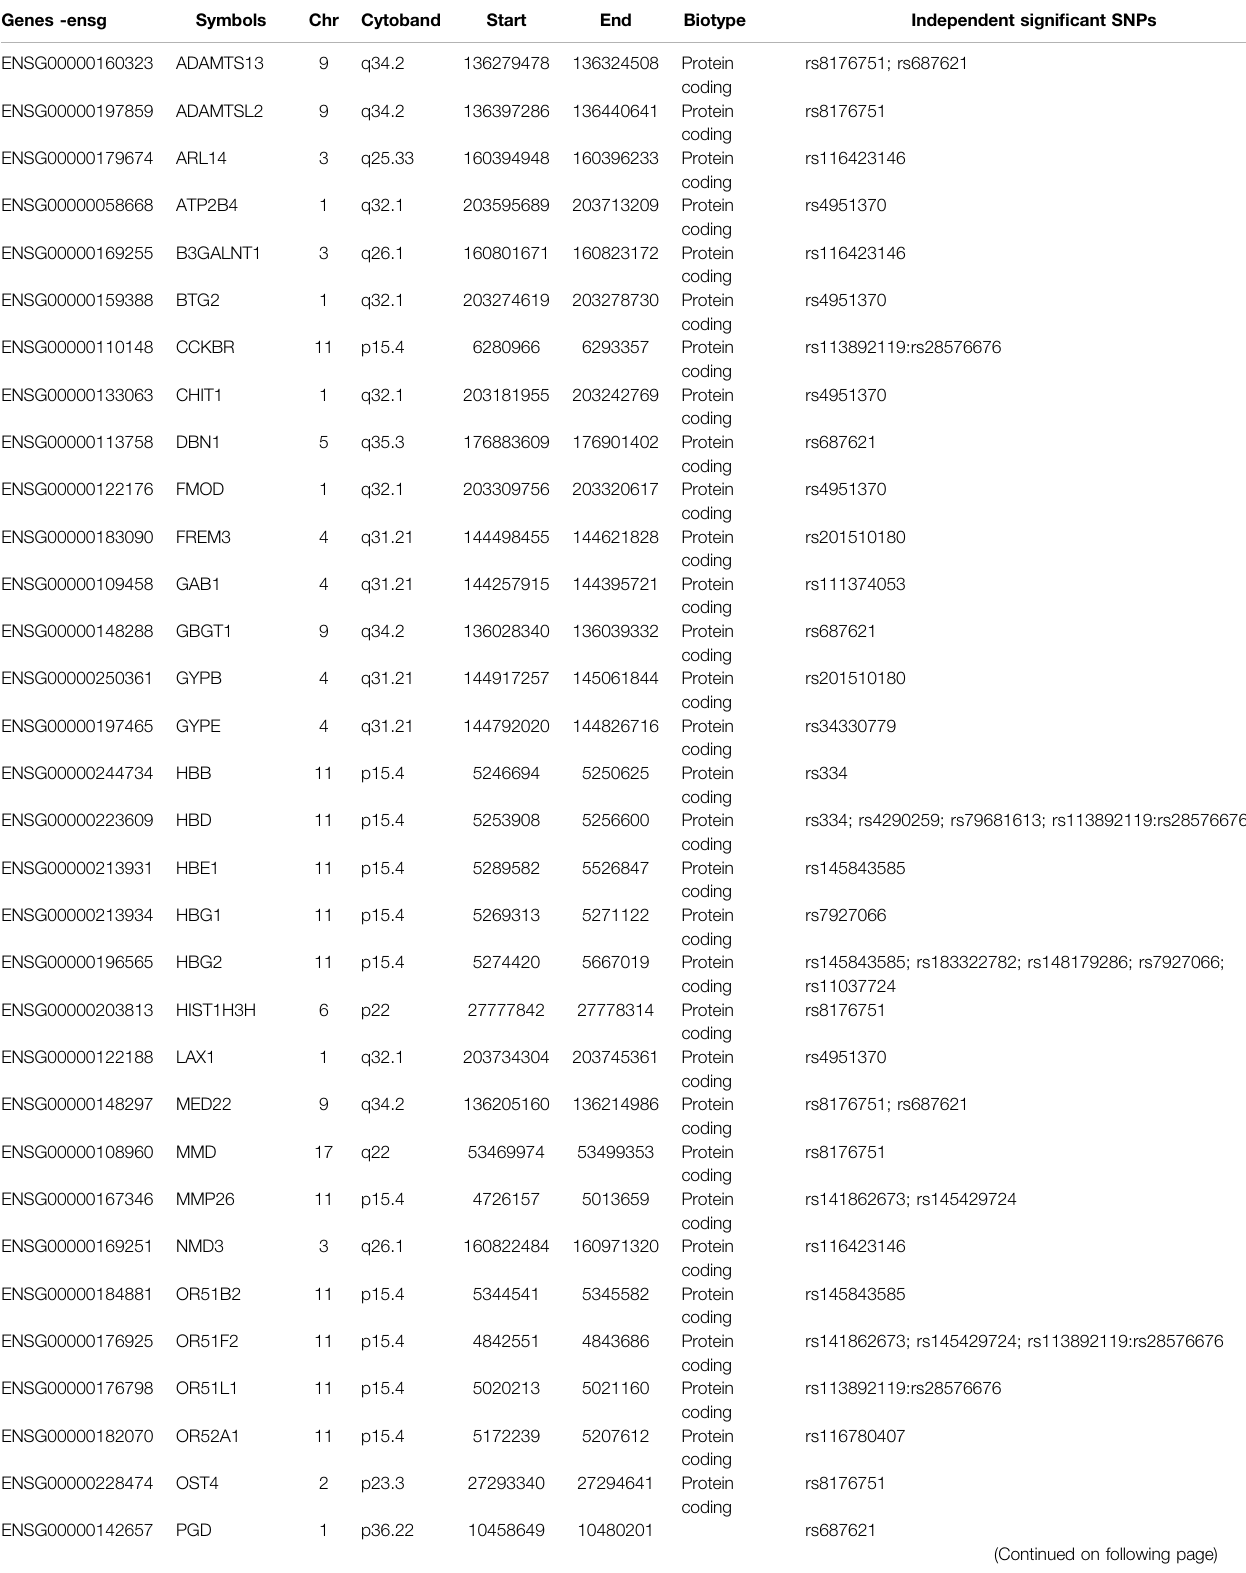
TABLE 1 | Fifty-seven severe malaria resistance candidate genes identi fi ed by eQTL mapping, chromatin interaction mapping, and positional mapping strategies implemented in FUMA. Genes